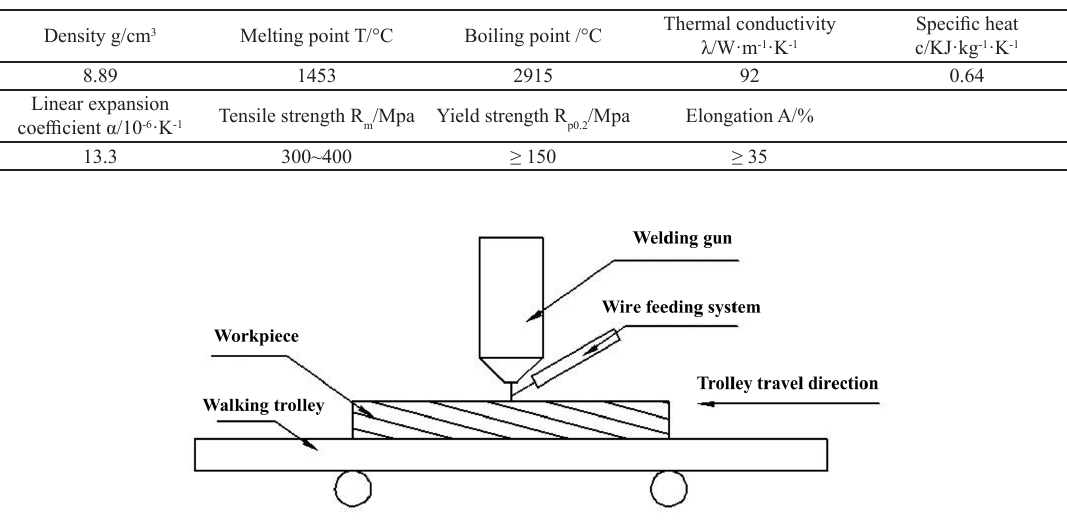
Table 2. The physical properties and mechanical properties of the N6 Density g/cm 3